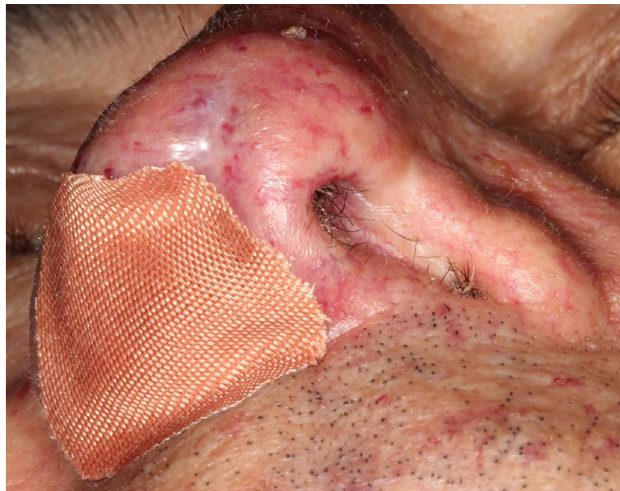
Fig. 2. Lower view of nose: complete closure of the nasal cavities as a result of Young ’ s procedure